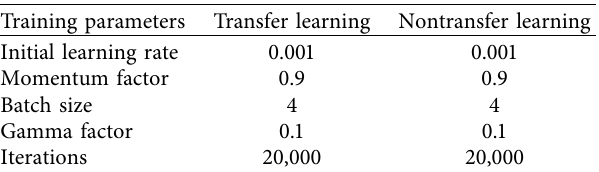
Figure 6: Technical flowchart for real-time semantic segmentation of sheep carcass images. Table 2: Training parameters of transfer learning and nontransfer learning